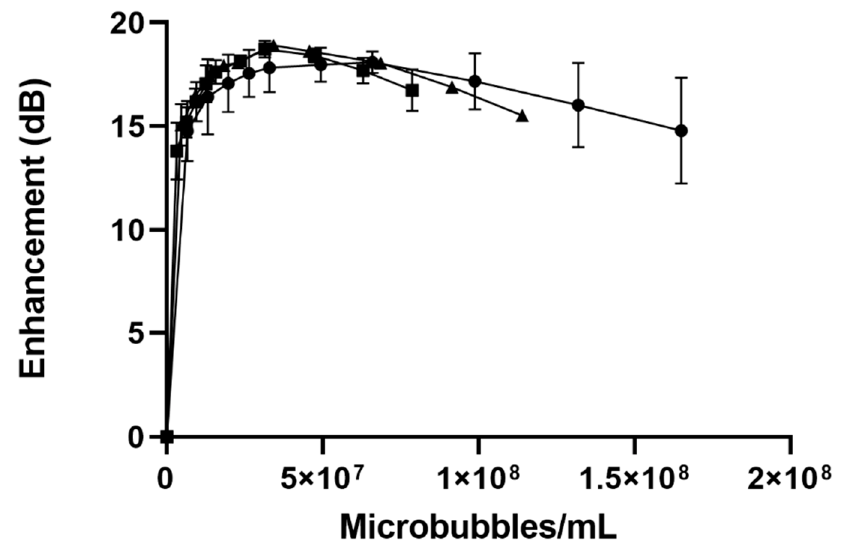
Figure 3. Effect of drug loading on dose-response curves (plotted as microbubbles/mL) for unloaded (- ● -), lonidamine (- ◾ -), and paclitaxel-loaded (- ▲ -) SE61 O2 microbubbles.